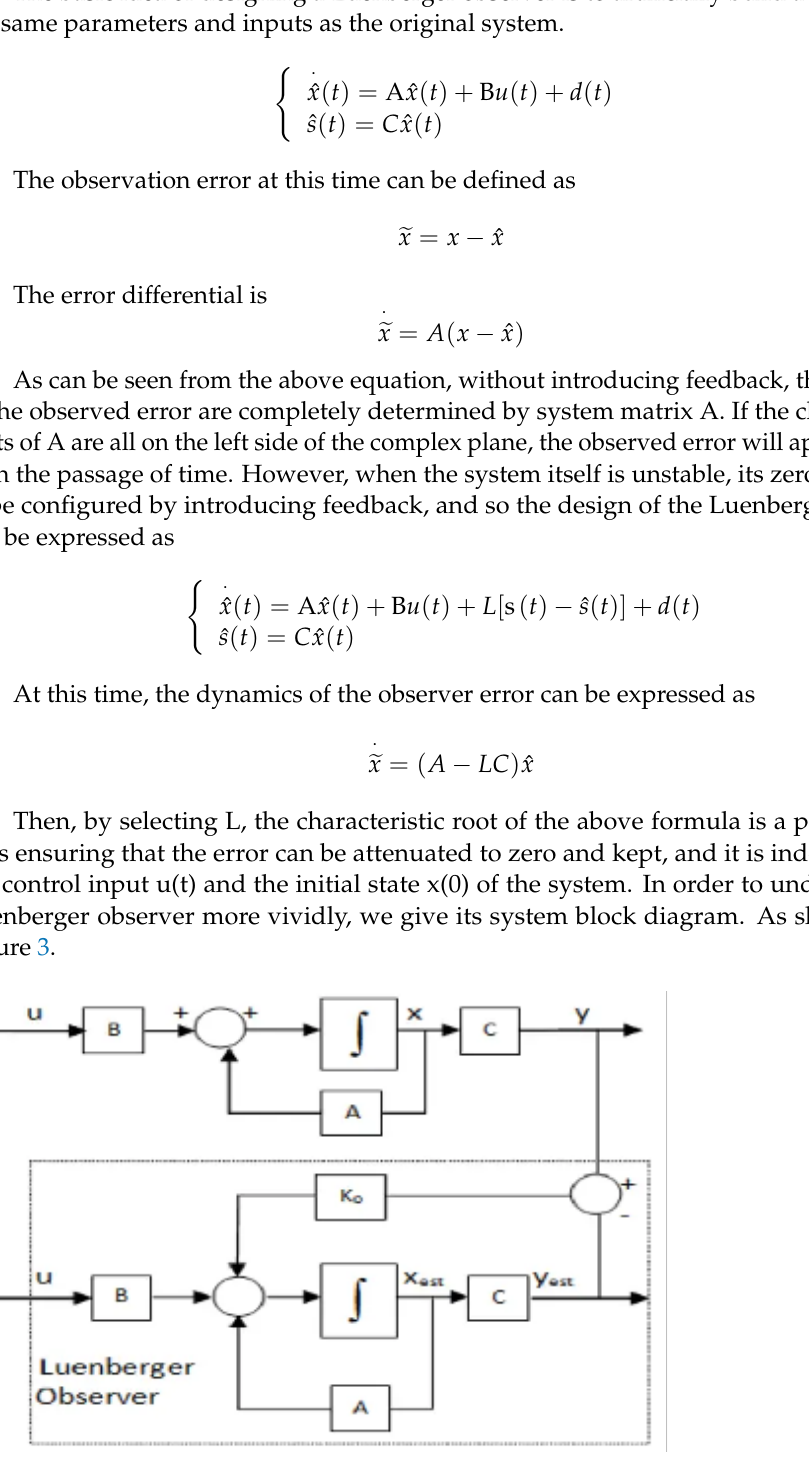
Figure 3. Luenberger observer. The Luenberger observer controls the observed measurement x ( t ) by introducing linear feedback. The essence of its control is to make it possible to track x ( t )